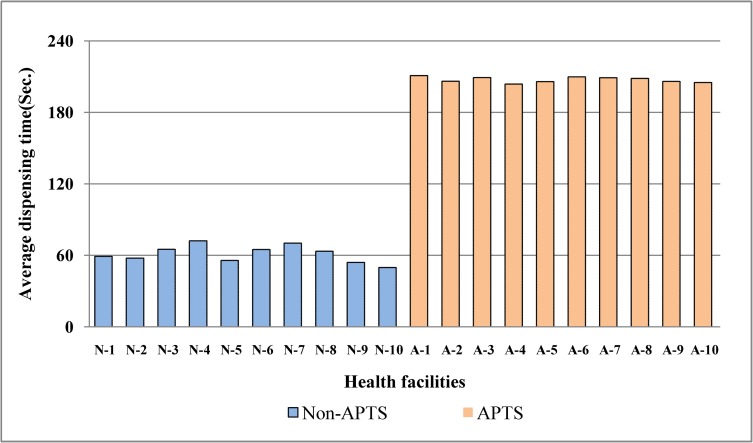
Average dispensing time in seconds between APTS and non-APTS facilities.N: Non-APTS facilities, A: APTS facilities.